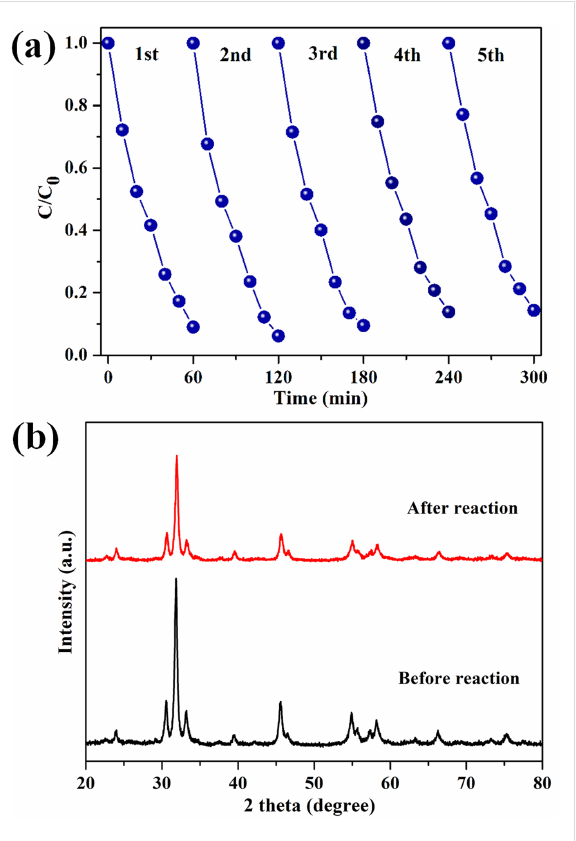
Figure 8: (a) The cycled photocatalytic degradation of RhB over 0.3AgI/Ag 2 WO 4 ; (b) XRD patterns of the fresh and used 0.3AgI/Ag 2 WO 4